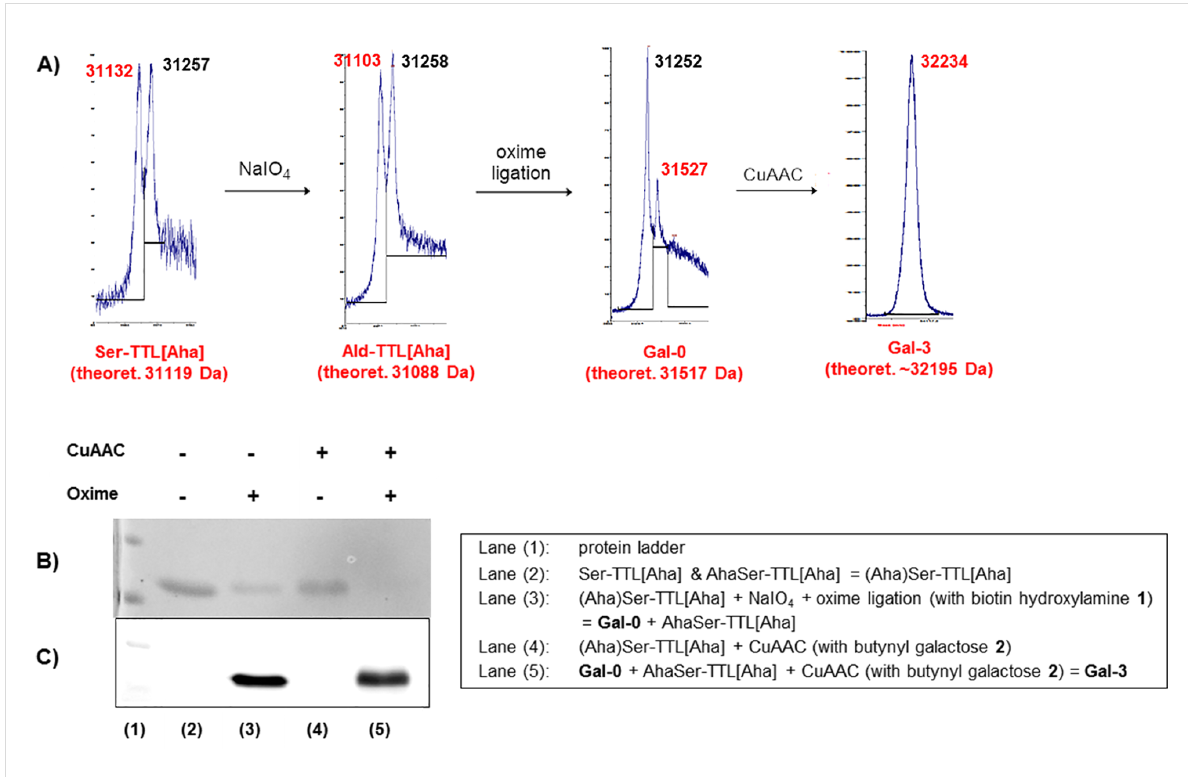
Figure 1: Dual-functionalization of TTL: A) MALDI–MS spectra (red: modified protein (as marked below); black: reference protein AhaSer-TTL[Aha]; m / z (calculated): [M+H] + 31245 Da; for full spectra see Supporting Information File 1) B) SDS PAGE of TTL protein conjugates (Coomassie stain), C) Western Blot (streptavidin-peroxidase